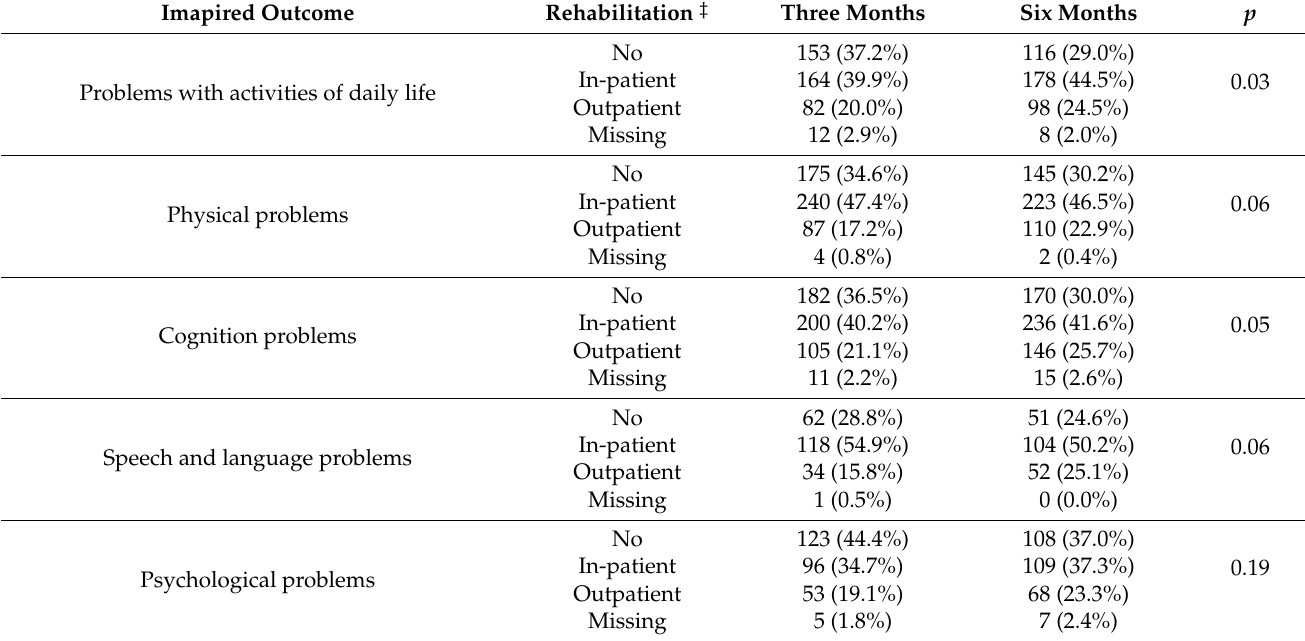
Table 5. Rehabilitation provided to patients with impaired